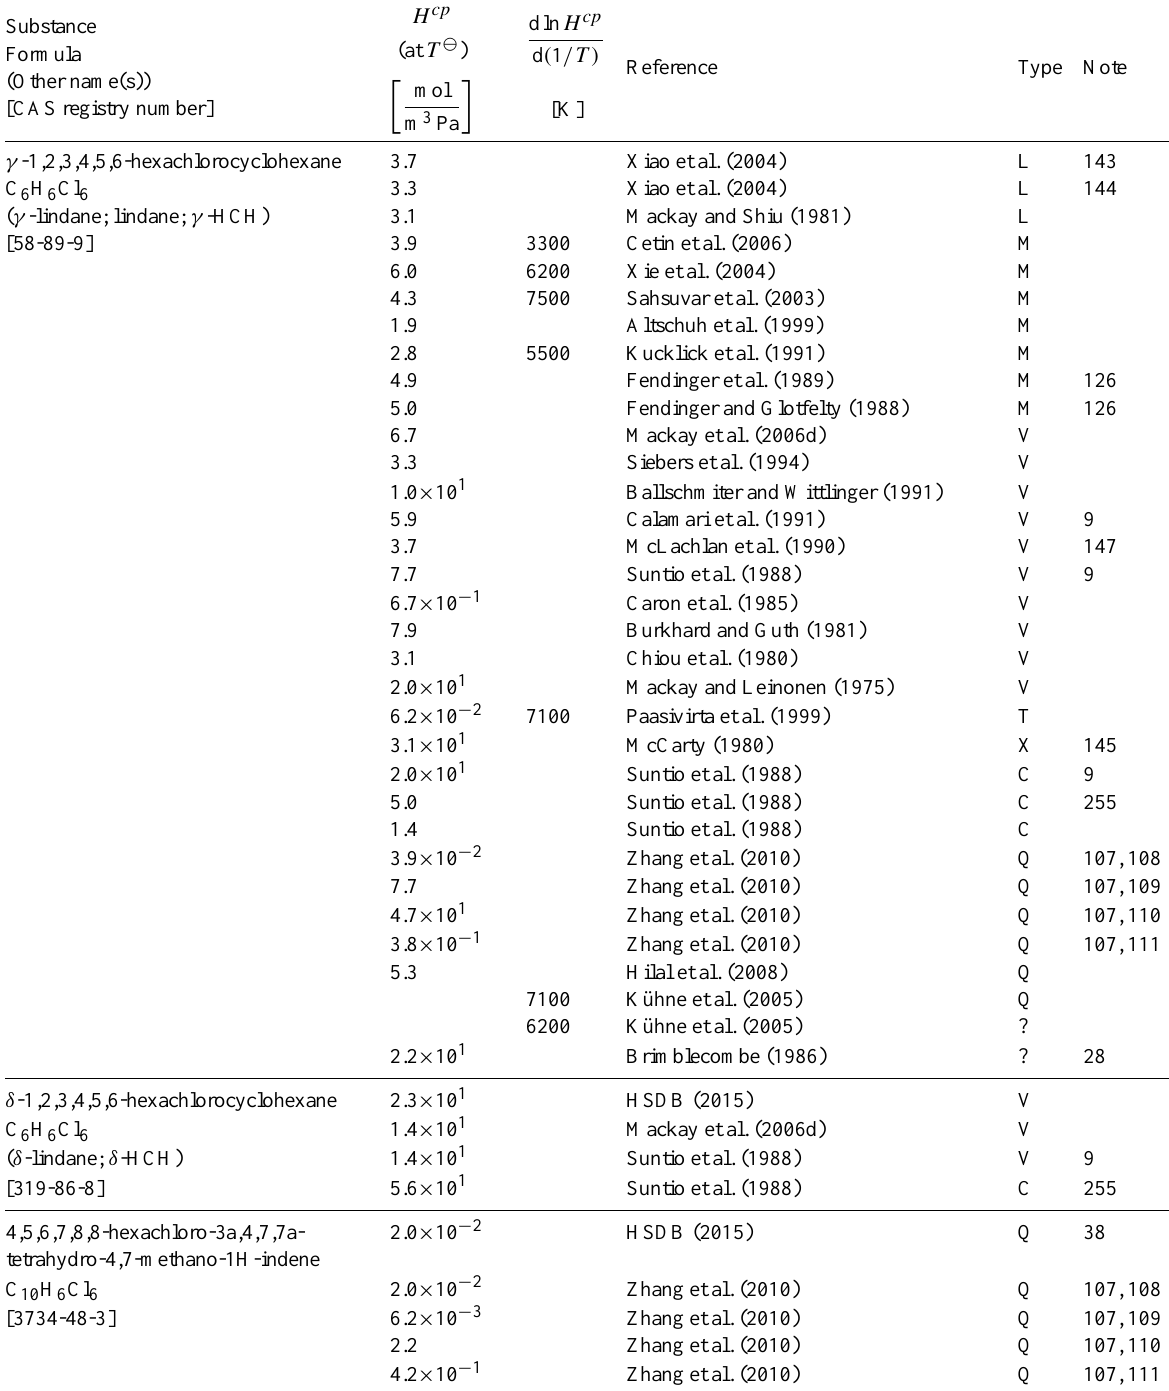
Table 6: Henry’s law constants for water as solvent